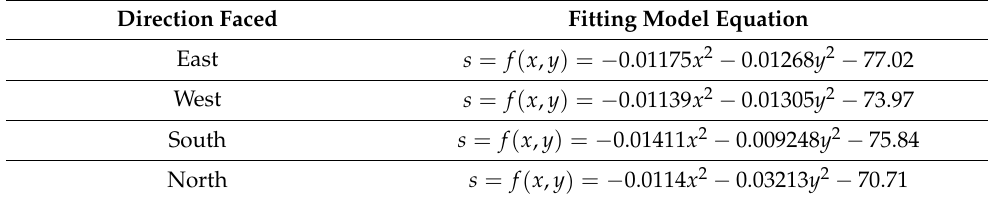
Figure 19. Fitting Model for Same Base Station Using Data Collected Facing North. Table 3. Individual Fitting Model Equations for the Same Base Station Using Data Collected from Different